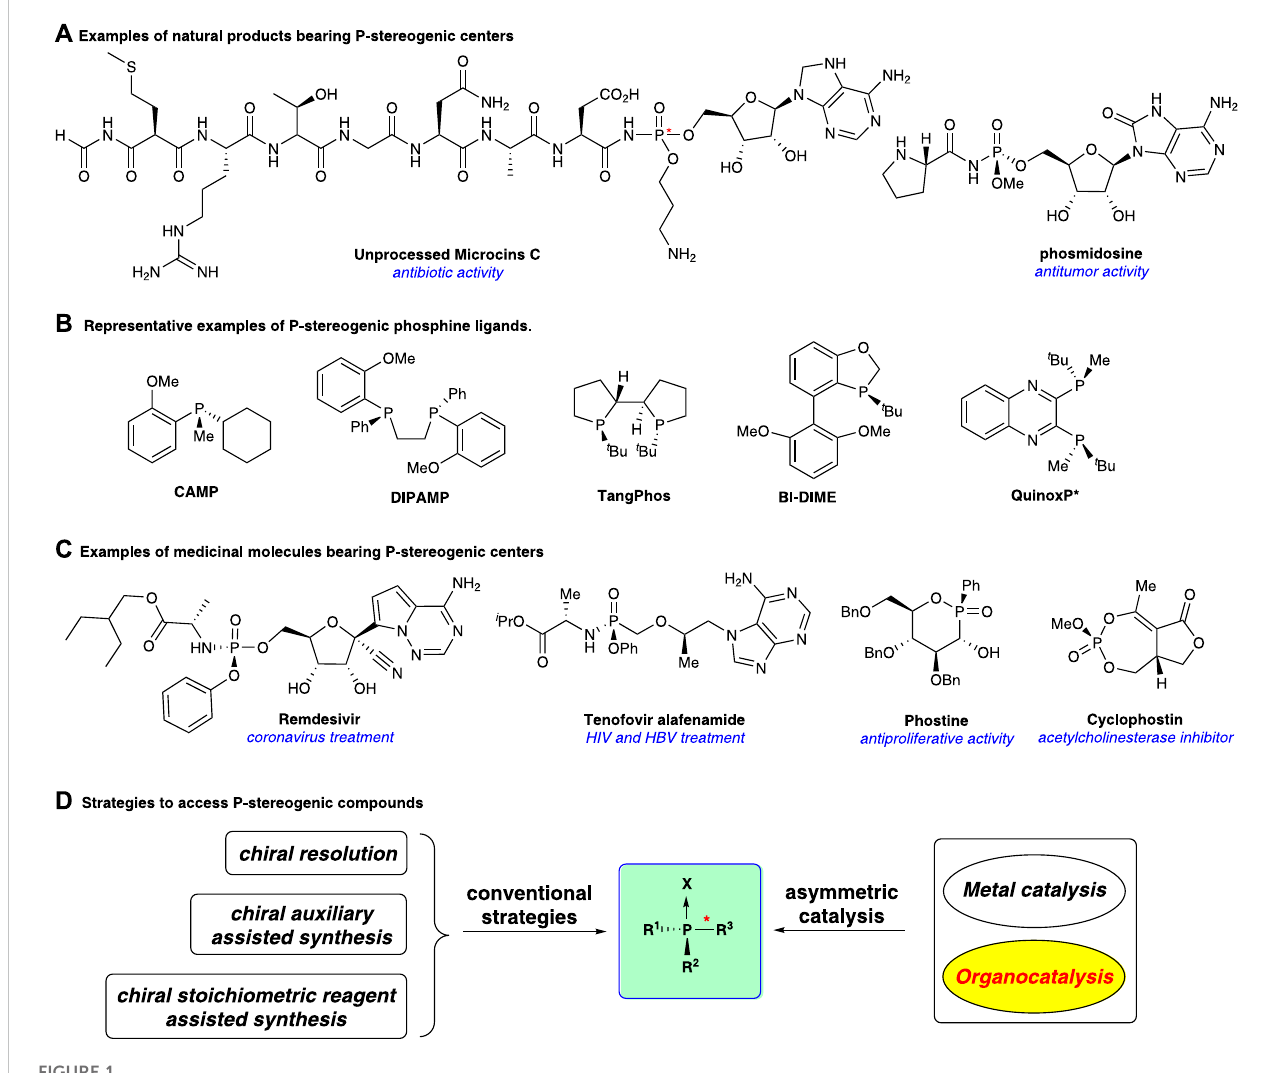
FIGURE 1 P-stereogenic compounds and the existing synthetic strategies. (A) : Examples of natural products; (B) : Examples of P-stereogenic phosphine ligands; (C) : Examples of medicinal molecules; (D) : Strategies to access P-stereogenic compounds.